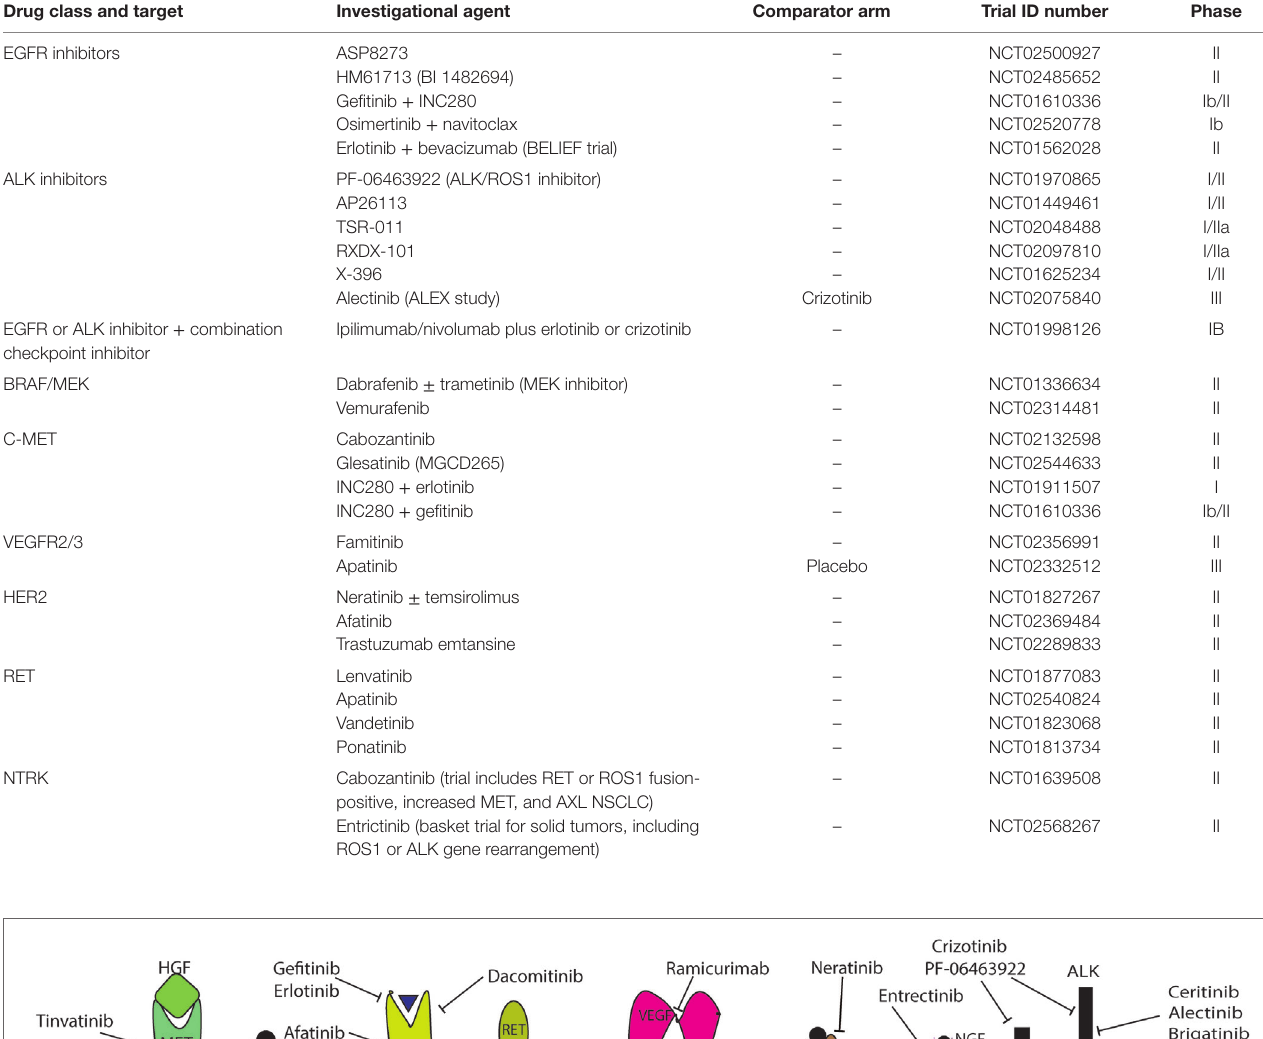
TABLe 1 | Selective ongoing non-squamous nSCLC targeted therapy trials.